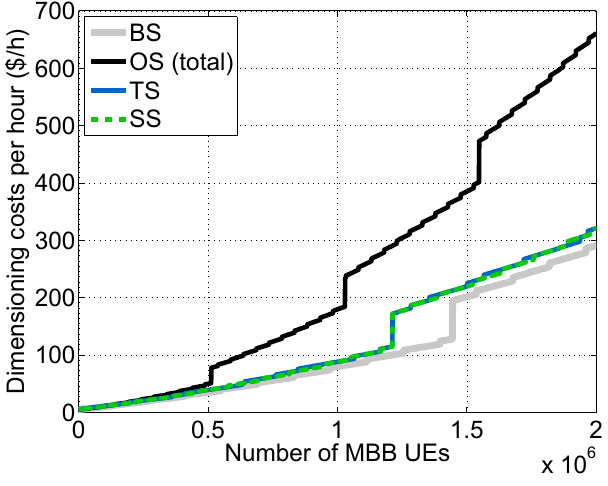
Figure 11. Dimensioning costs comparison per evaluated